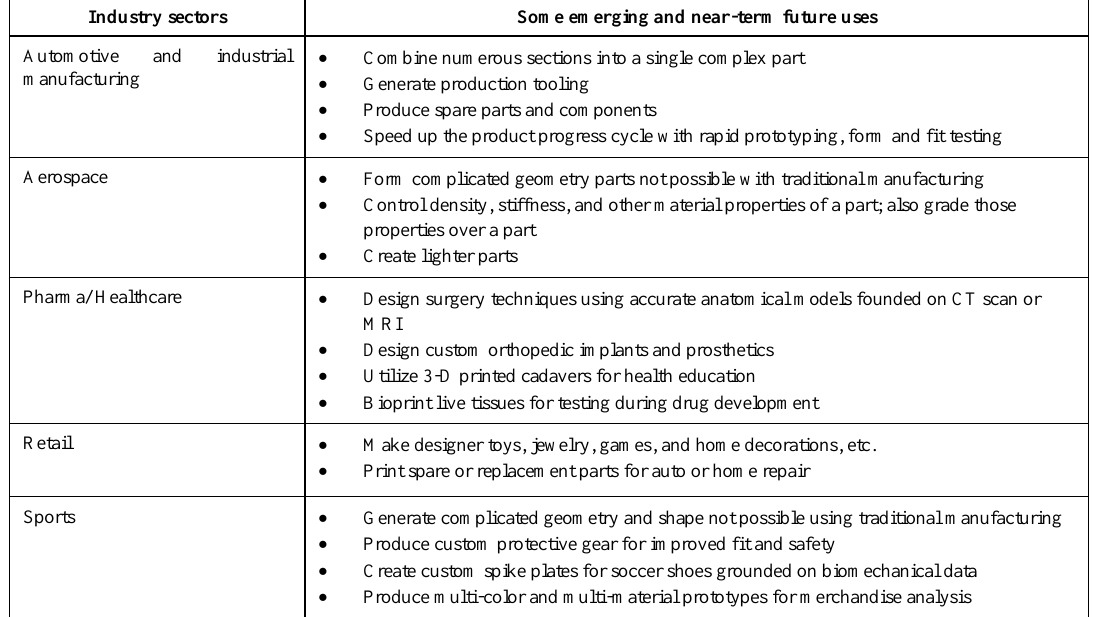
Table 4. Developing uses of 3-D printing in different manufacturing